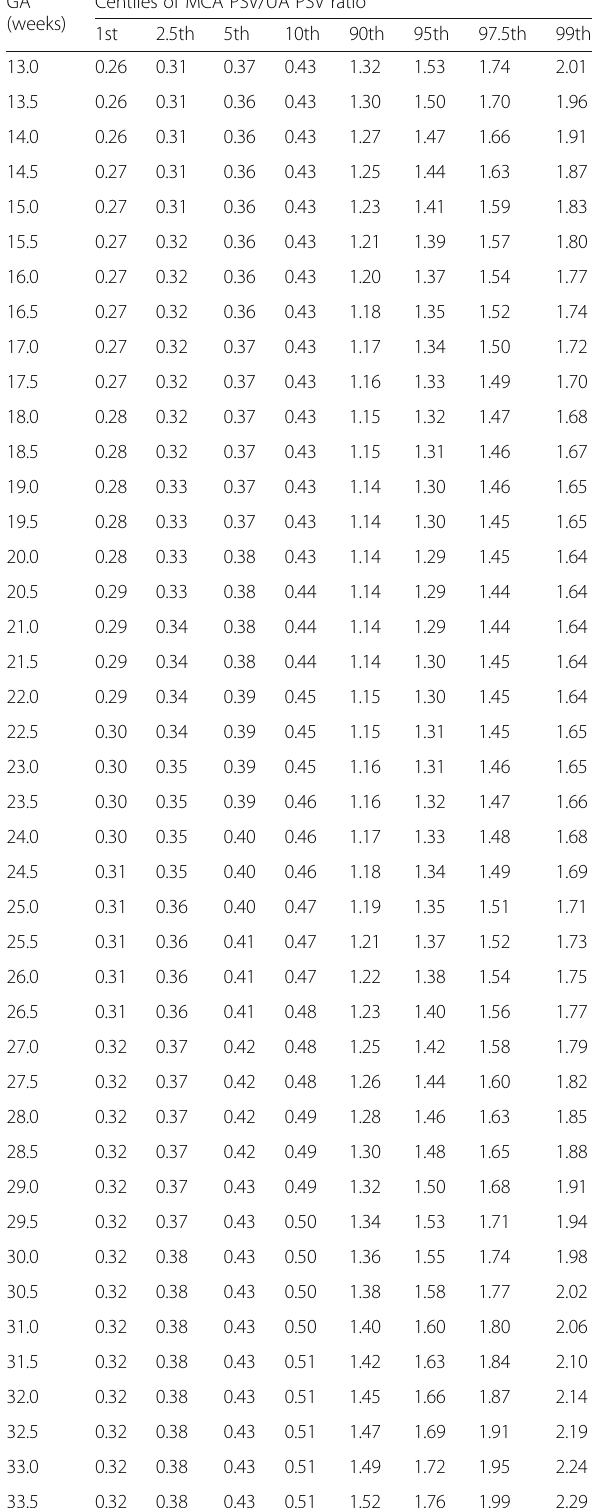
Table 2 Gestational age-defined reference ranges for MCA PSV/ UA PSV ratio GA Centiles of MCA PSV/UA PSV ratio (weeks)